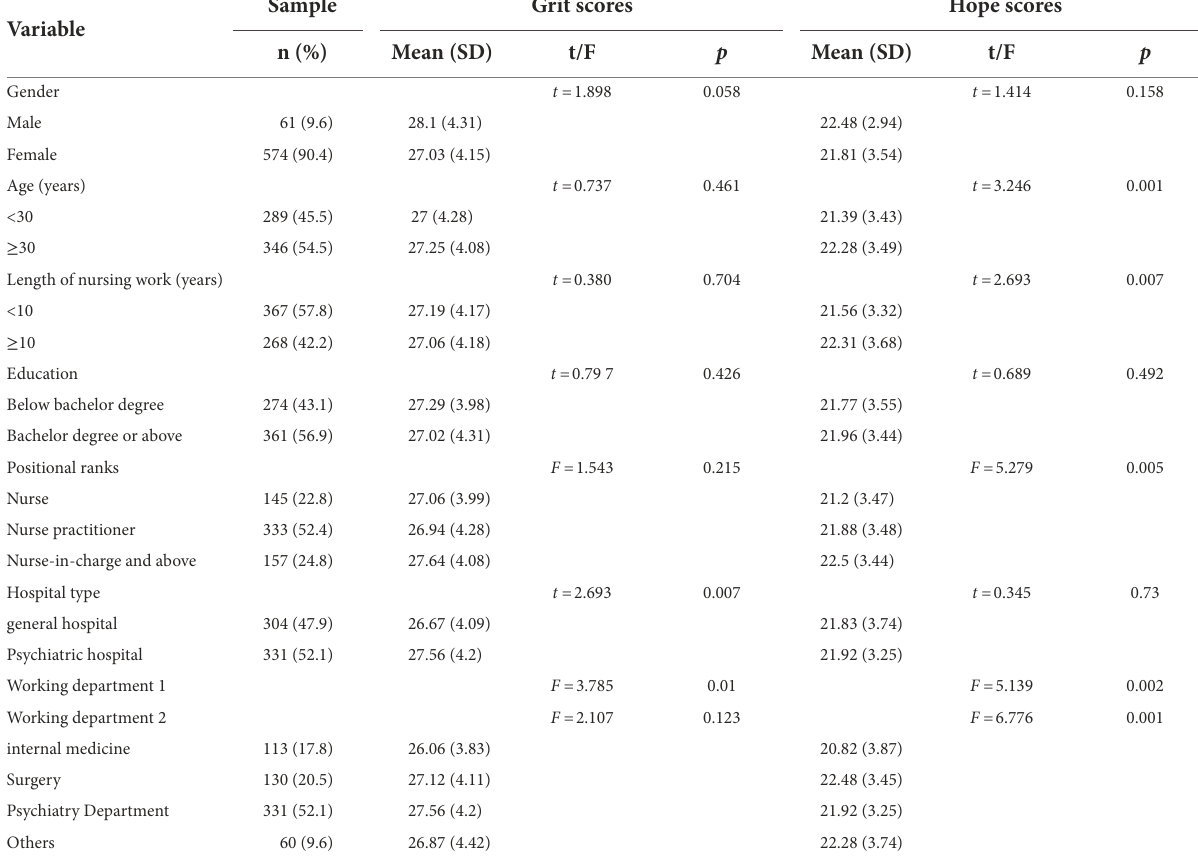
TABLE 1 Demographic characteristics of research objects ( n =